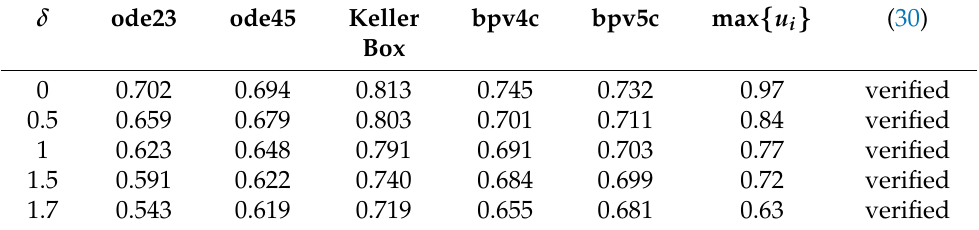
Table 1. Range of θλ ensuring convergence without ghost solutions. δ ode23